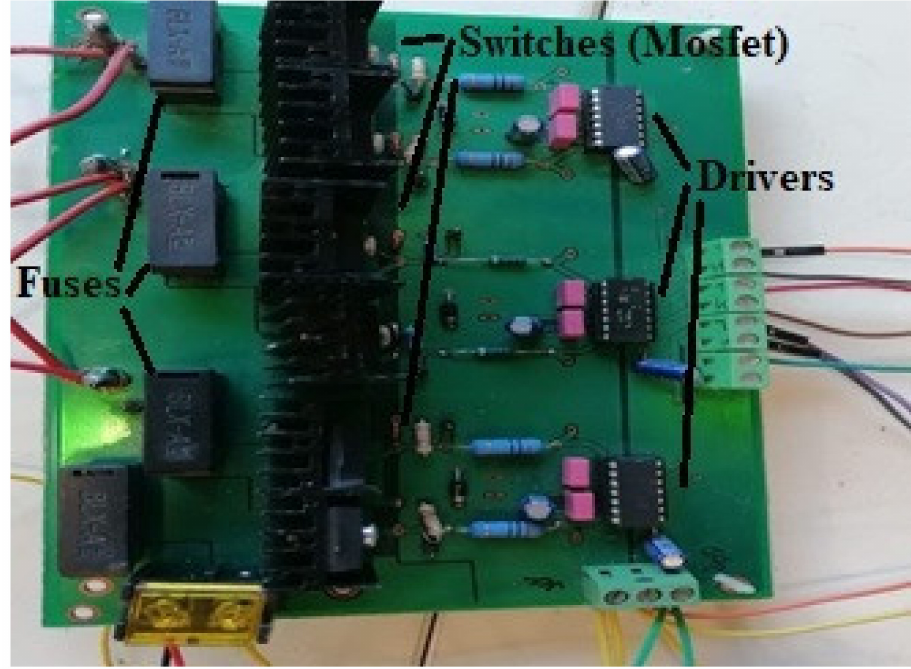
Figure 21. Inverter PCB